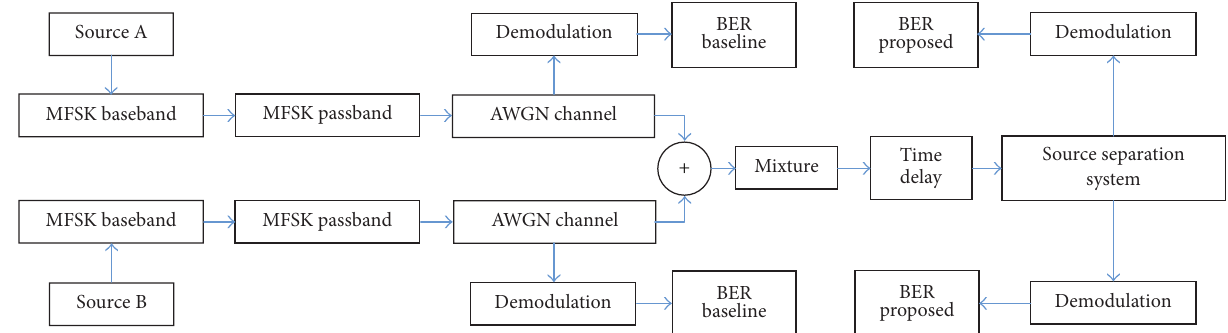
Figure 9: The illustration of stacking deep autoencoder and softmax classifier.